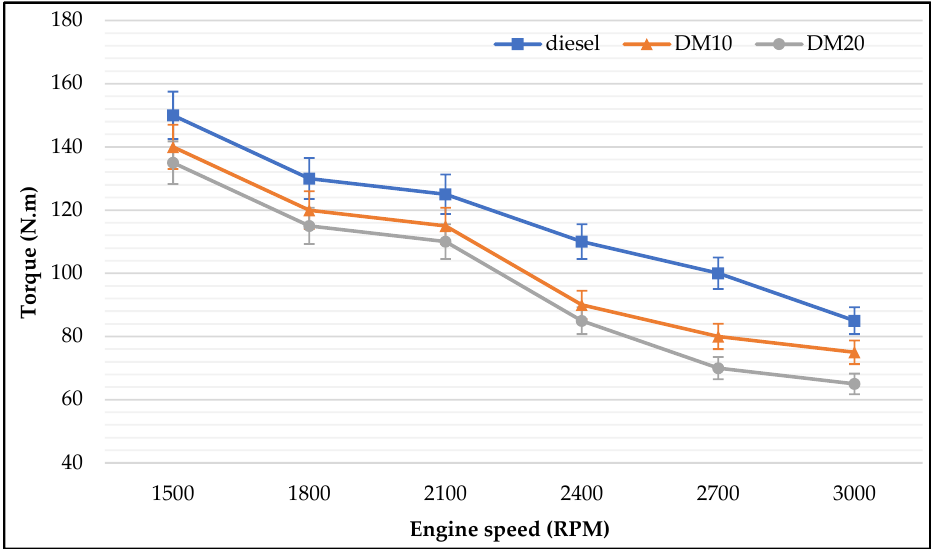
Figure 11. Engine torque, at different engine speeds.